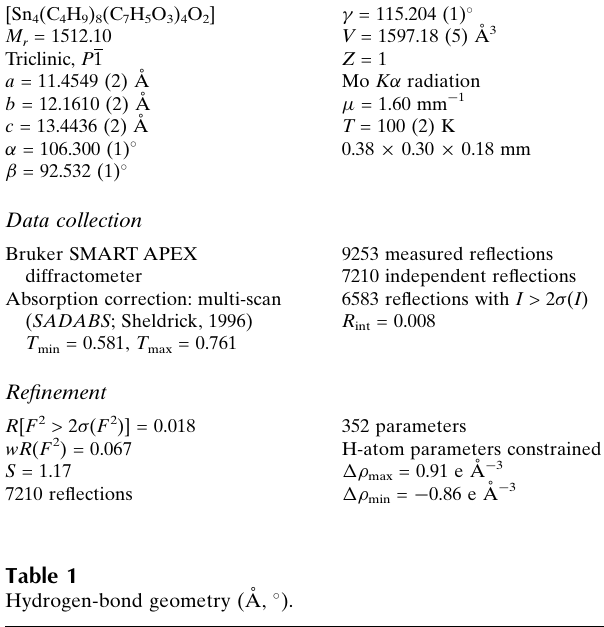
centrosymmetric tetranuclear compound,